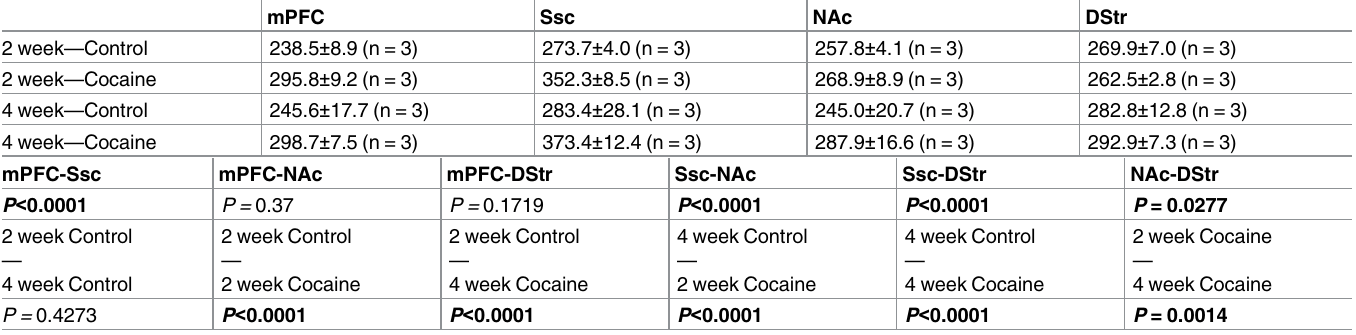
Table 2. Microvascular density (mean ± Std) in different brain regions including mPFC, Ssc, NAc and DStr, following cocaine treatment for 2 weeks and 4 weeks. P values calculatedusing two-way ANOVA (SAS) are listed below. Significant P values ( P < 0.05)are bolded.